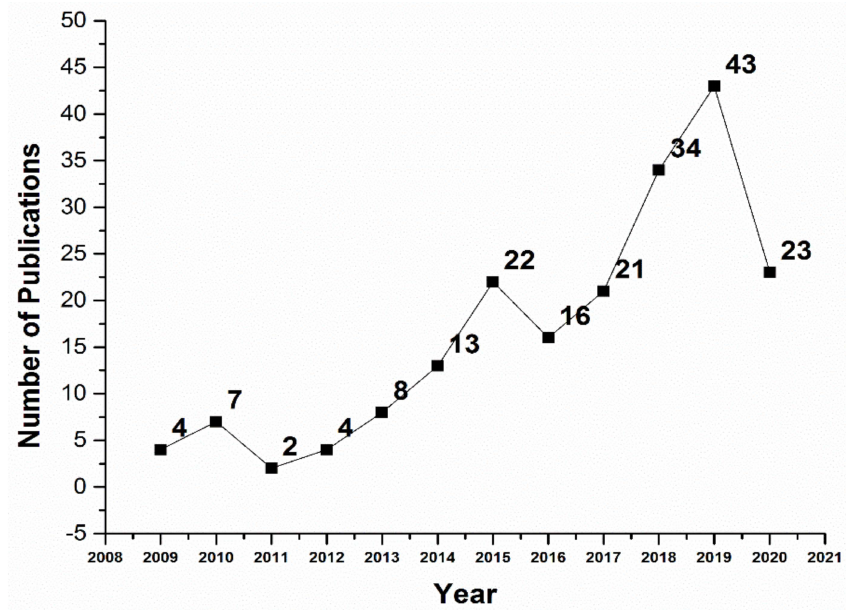
Figure 2. Year vs. no of publications.